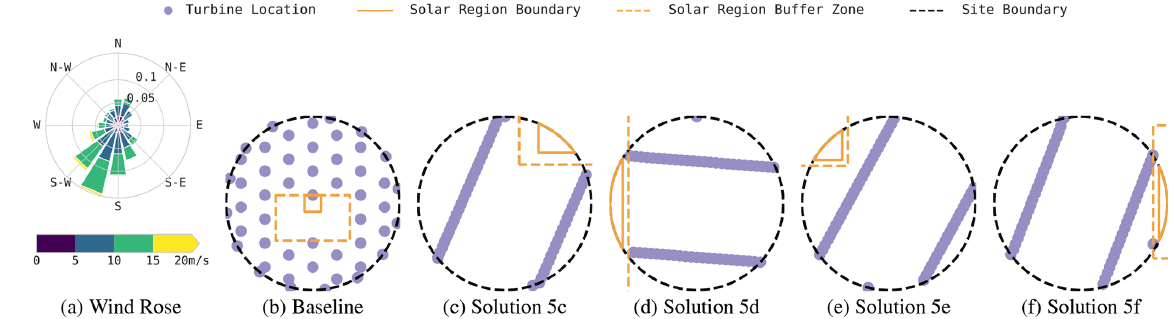
Figure 6. CMA-ES solutions for the high-correlation location and circular boundary. Turbine locations are marked in purple, the solar region is drawn with an orange solid line, and the surrounding solar buffer zone is marked with a dashed orange line.